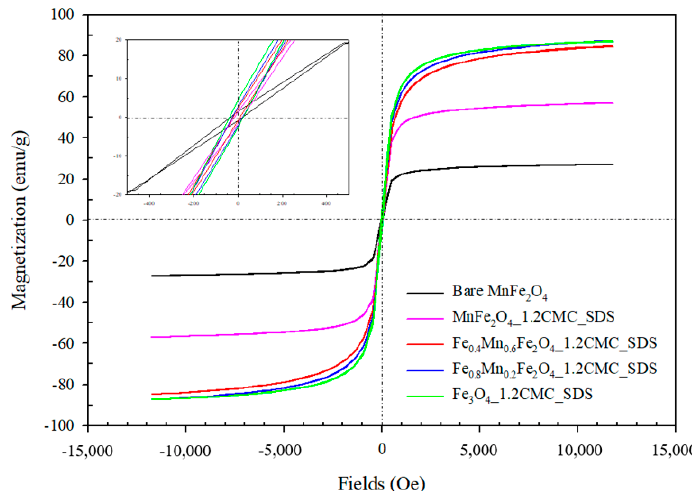
Figure 7. Magnetization of the synthesized bare MnFe 2 O 4 and Fe (1-x) Mn x Fe 2 O 4 _1.2CMC_SDS ferrite nanoparticles.